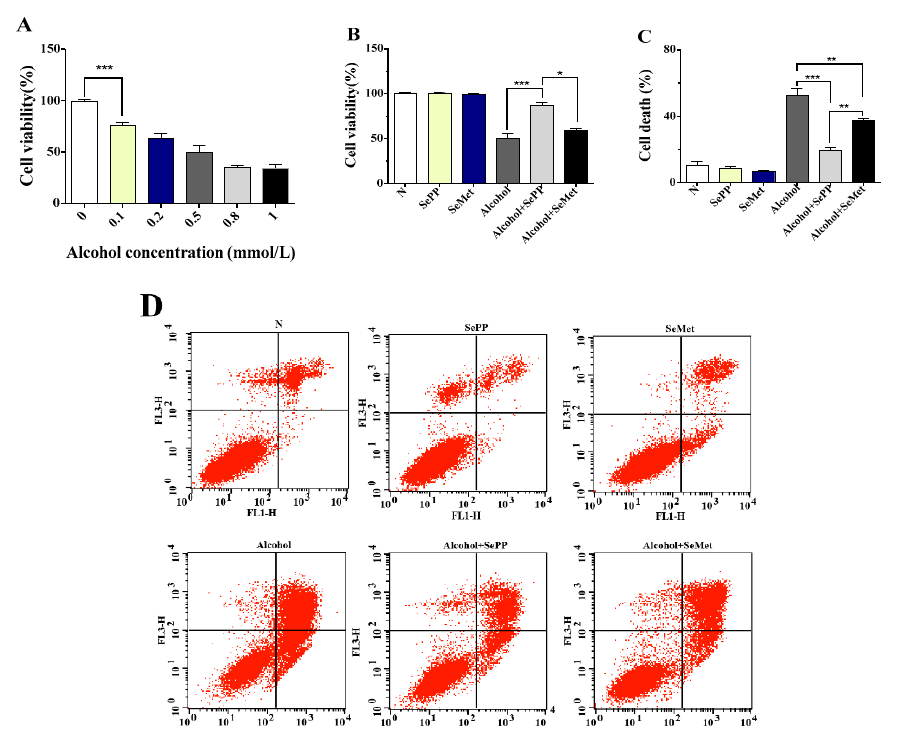
Figure 2. Preventive effects of SePP and SeMet on ALD in a cell culture model. AML-12 cells were treated with different concentrations of alcohol ( A ), effects of alcohol and selenium compounds on cell viability ( B ), and cell death ( C ), flow cytometry scatter plot of cell death ( D ), Data were expressed as mean ± SEM ( n = 6), * p < 0.05, ** p < 0.01, *** p < 0.001 (the same below unless otherwise notified).